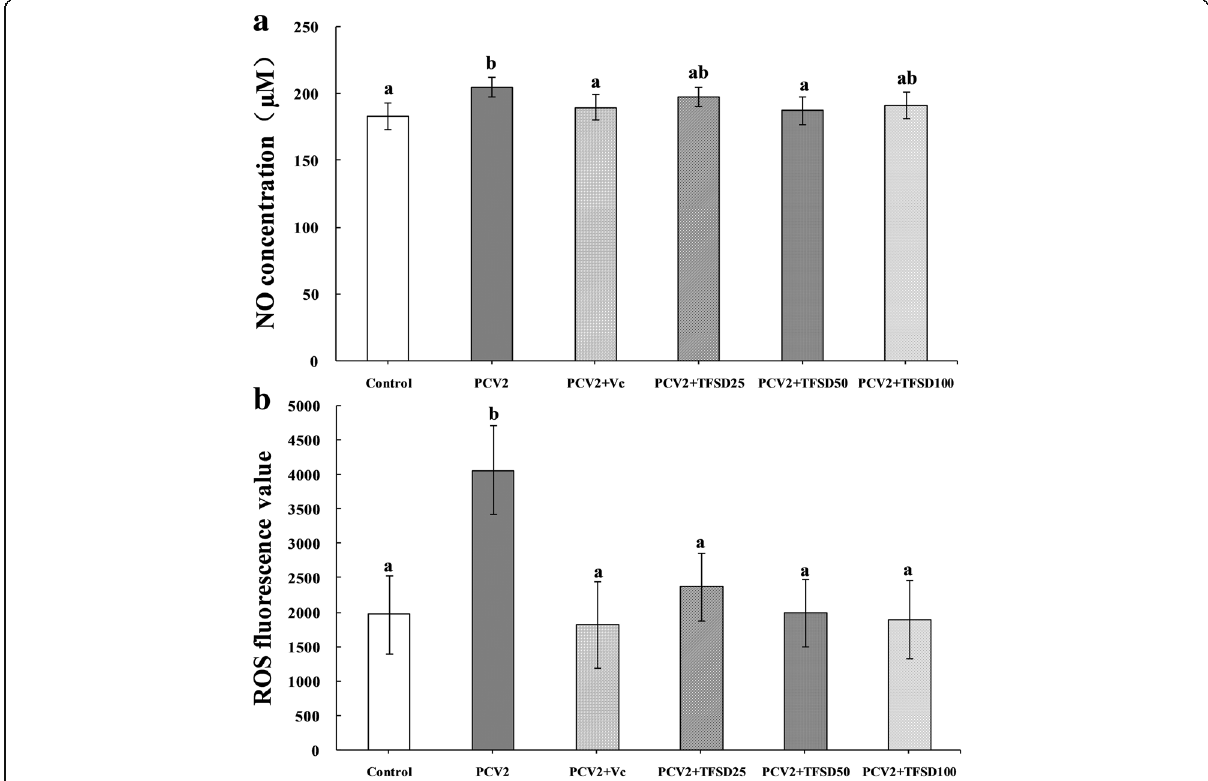
Fig. 2 Effect of TFSD on NO secretion ( a ) and ROS production ( b ) in PCV2 infected RAW264.7 cells. Data are presented as mean ± S.D. Bars with different letters are statistically different ( P < 0.05). Control: cells without PCV2 infection and drug treatment; PCV2: cells infected with 10 2.7 TCID 50 PCV2; PCV2 + Vc: cells treated with 100 μ g/mL of vitamin C after PCV2 infection; PCV2 + TFSD25 – 100: cells treated with TFSD at concentrations of 25, 50 or 100 μ g/mL after PCV2 infection,